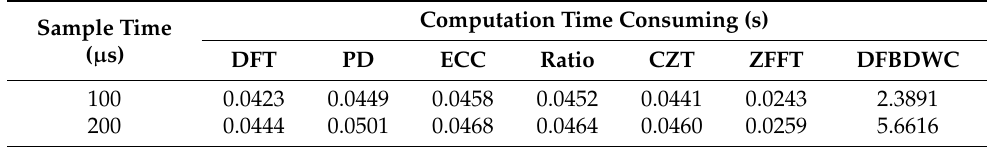
Table 7. The comparison of average computation time consuming between seven